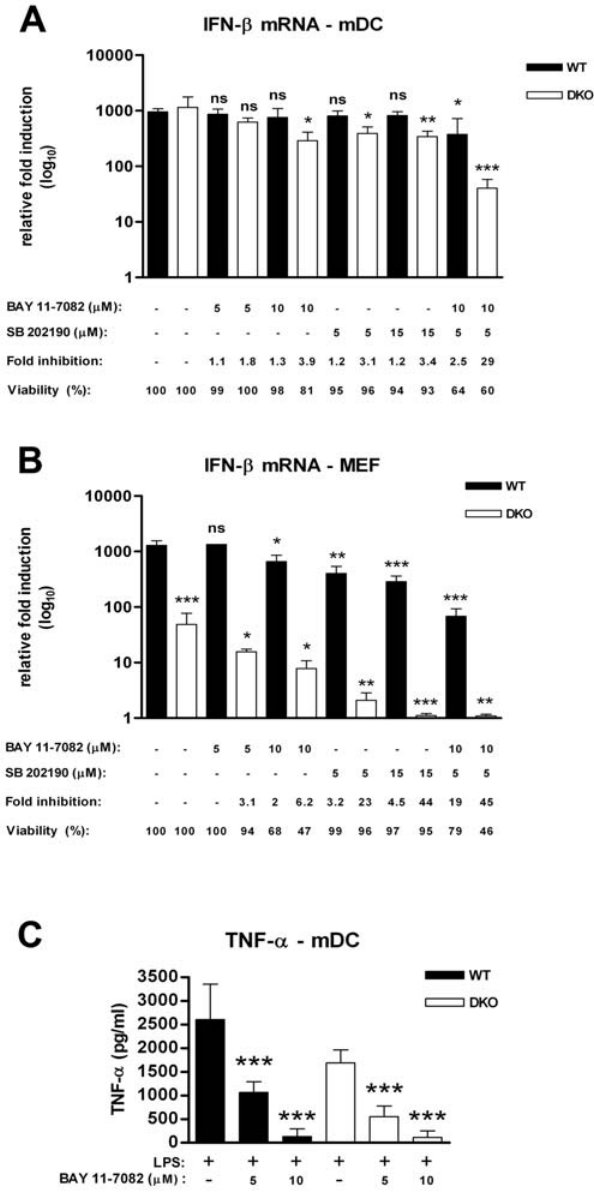
Figure 9. Pharmacological inhibition of NF- k B and p38 in wild type and DKO mDC and MEF. A–B . mDC ( A ) and MEF ( B ) generated from wild type and DKO mice were infected at an MOI of 0.1 in the presence of 1% DMSO or increasing concentrations of BAY 11-7082 (in 1% DMSO) and/or increasing concentrations of SB 202190 (in 1% DMSO). Levels of IFN- b mRNA were evaluated at the indicated times post- infection by qRT-PCR. Cell viability was analyzed using a cytotoxicity assay as described in the Materials and Methods. C . Efficiency of BAY 11-7082 in inhibiting NF- k B transcriptional activity. Wild type and DKO mDC were treated with 1% DMSO or 5 m M and 10 m M of BAY 11-7082 and stimulated with LPS (2 m g/ml) for 24 hours. Levels of secreted TNF- a were measured by ELISA. Values are an average of duplicate samples generated from three independent experiments. Asterisks indicate values thatarestatistically significant (***, P , 0.0001, **, P , 0.005, *,P , 0.05); n.s. indicates differences that were not statistically significant.